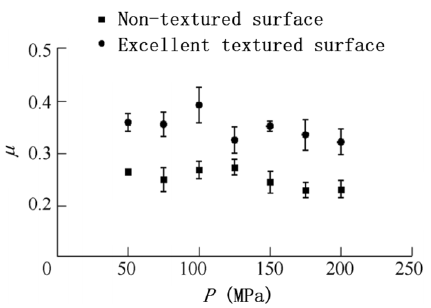
Figure 11 Comparison of static friction